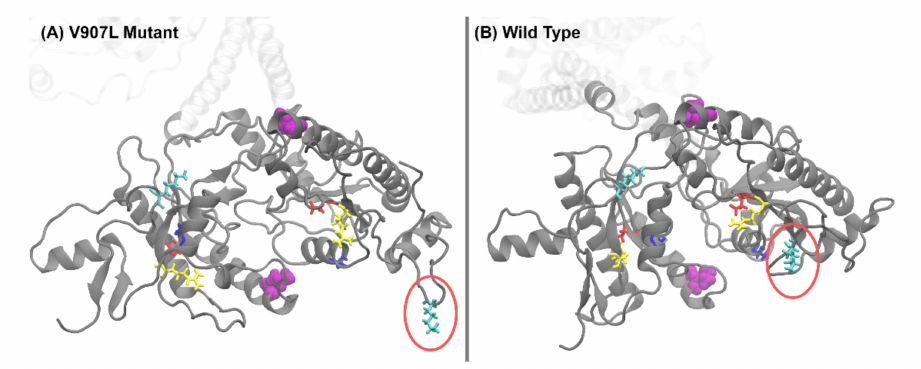
Figure 8. Critical amino acid positions in the putative GTP substrate-binding site in GC-E. Panels ( A ) and ( B ) show the catalytic domain for the V907L mutant and WT GC-E, respectively. The residues comprising the binding site are represented by sticks and colored according to their type (blue = Ala, lime = Arg, red = Asp, cyan = Lys). In one of the subunits of the GC-E structure, Lys1051 exhibits significant movement as it swings out (red ellipsoid). Occurrences of residue 907 are highlighted in